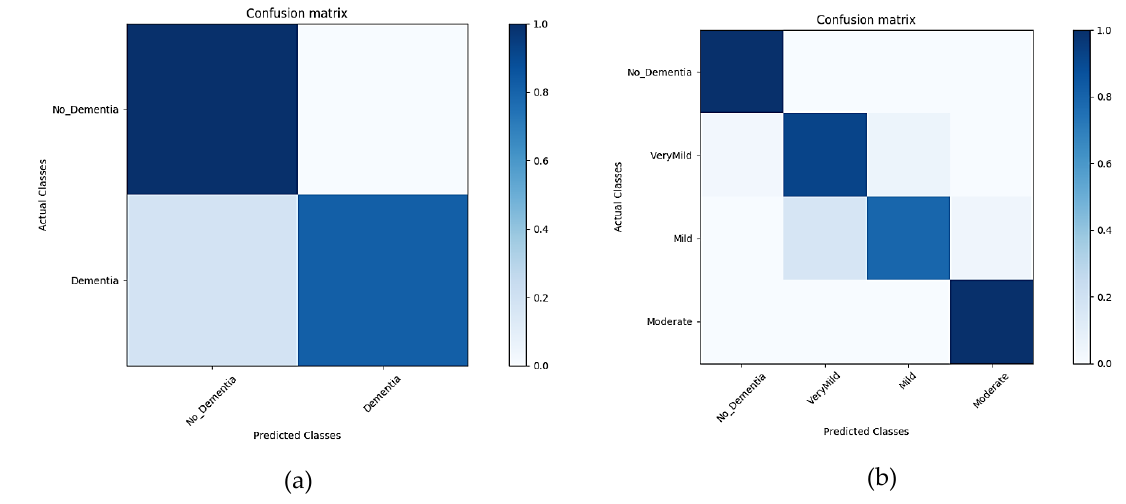
Figure 10. Confusion matrix of un-segmented images ( a ), representing the confusion matrix of a binary dataset. ( b ) A confusion matrix of multiple classes.